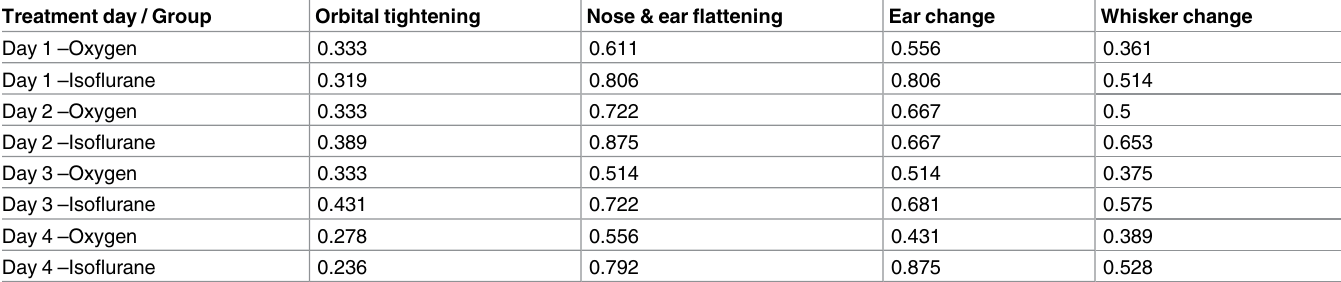
Table 1. The mean scores for each individual action unit, on each day for each surgical duration treatment group. Treatment day / Group Orbital tightening Nose & ear flattening Ear change Whisker